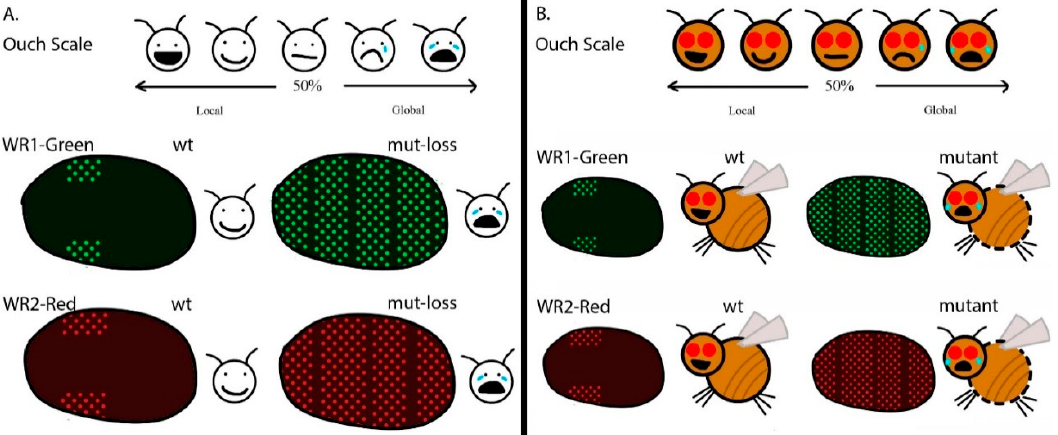
Figure 2. Highlights of the fruit fly in creative illustrations. ( A ) Simple “ouch scale” illustration. ( B ) Enhanced “ouch scale” illustration.